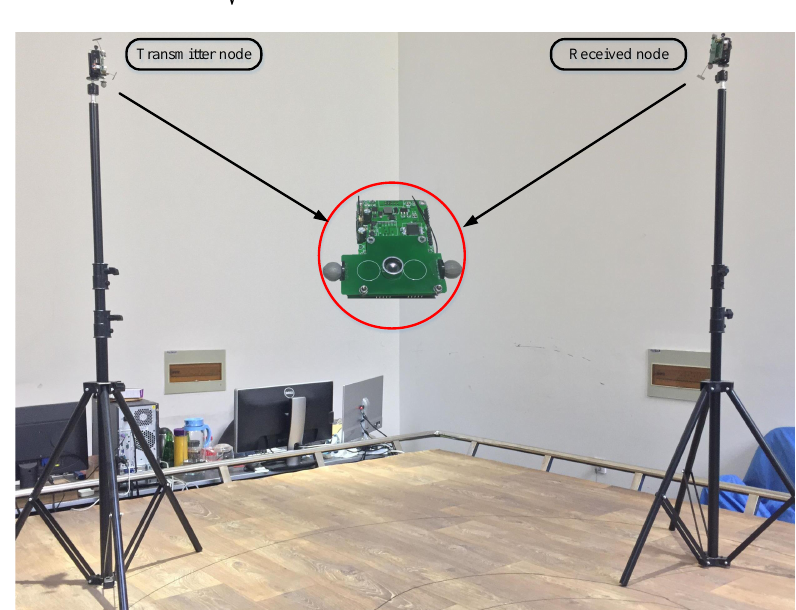
Figure 11. An illustration of the distance measurement between two nodes.